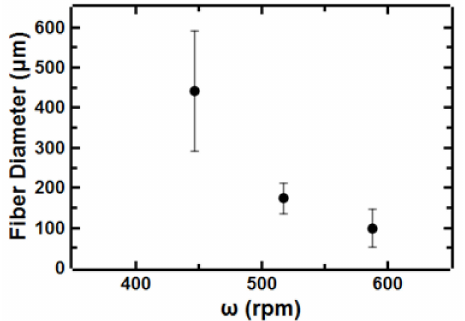
Figure 6. Effect of rotational speed of the collector on fiber diameter 30 wt.% polystyrene in 7:3 toluene:acetone and a 22G needle tip as a model